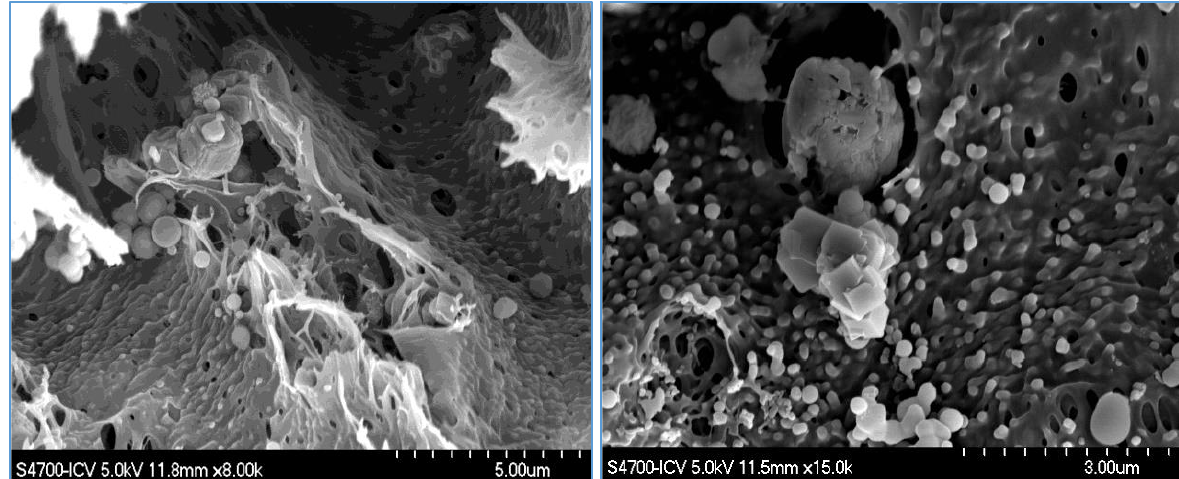
Figure 6: SEM micrographs from the cross-section of the MMM s with 20wt.% zeolite fillers showing interfacial